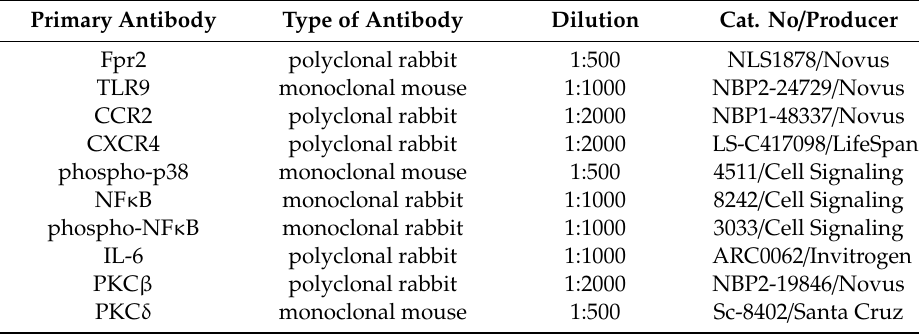
Table 2. List of primary antibodies used for Western blot analysis. Primary